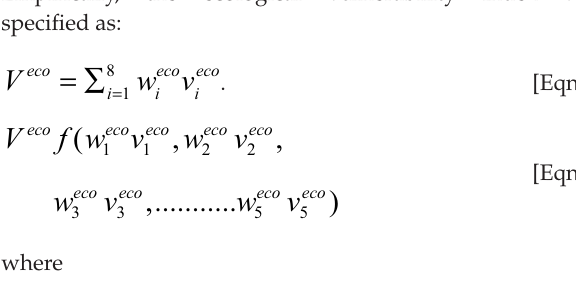
TABLE 1: Classification criteria of selected ecological vulnerability indicators. Ecological indicators Index Overgrazing 1 Zero land overgrazing Percentage of